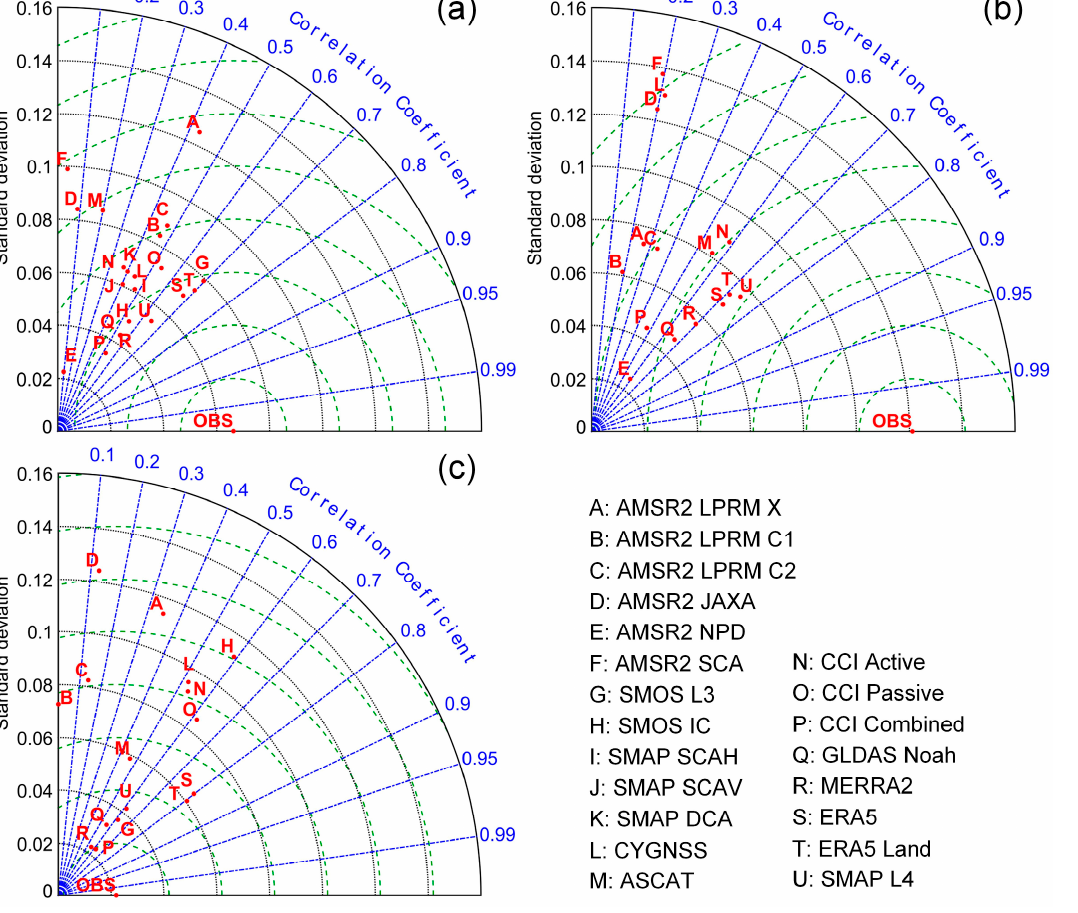
Figure 3. Taylor diagrams of all soil moisture products at two cropland stations ( a , b ) and one forest land station ( c ). The stations are ( a ) No. 2, ( b ) No. 8 and ( c ) No. 20 in Figure 1. Note that the letters are not shown if no data are available.